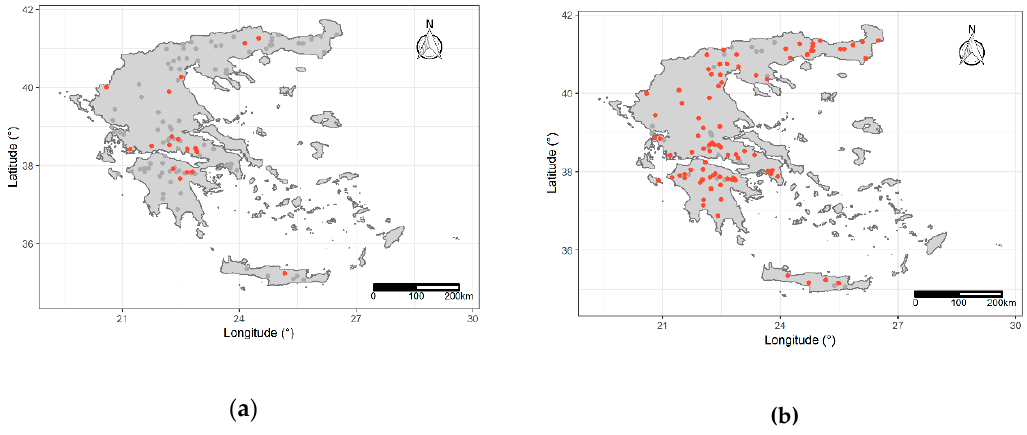
Figure 3. In these figures, the different subsets of stations used in the analysis are presented with red color: ( a ) Stations used for the temporal trend analysis; ( b ) Stations used for the clustering analysis.